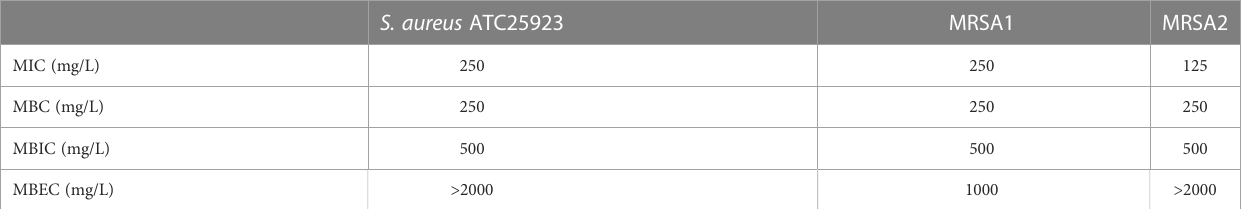
TABLE 1 Minimum inhibitory concentration (MIC), minimum bactericidal concentration (MBC), minimum bio fi lm inhibitory concentration (MBEC), minimum bio fi lm eradication concentration (MBEC) of the different strains used in this study.